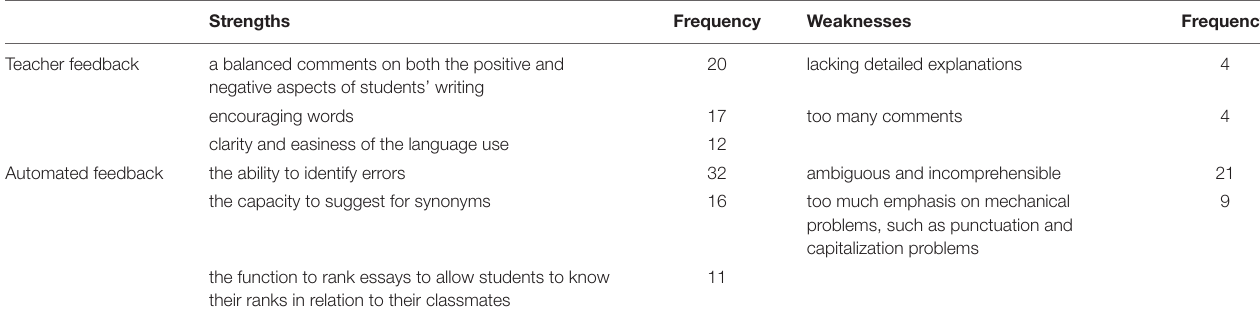
TABLE 3 | Themes of the strengths and weaknesses of teacher feedback and automated feedback.